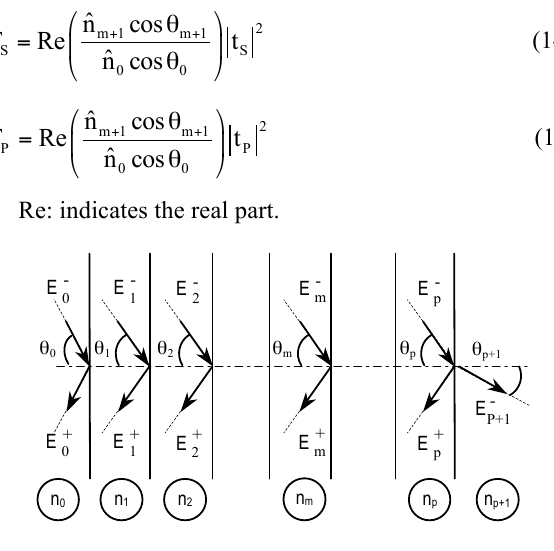
Figure 3: Multi-layer system with p components.